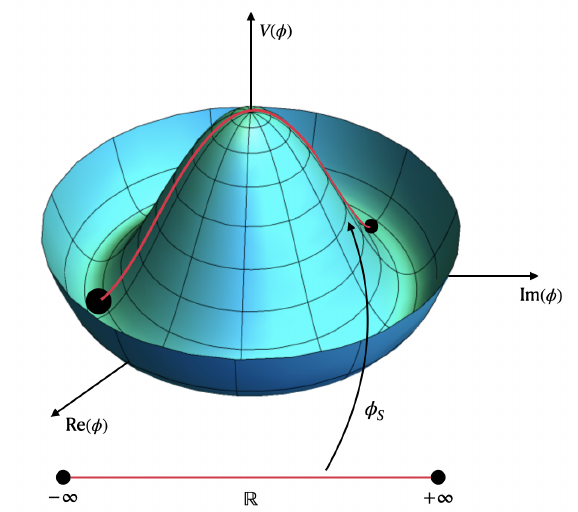
Figure 2. Complex kink solution, which corresponds to the mapping from R to the scalar field